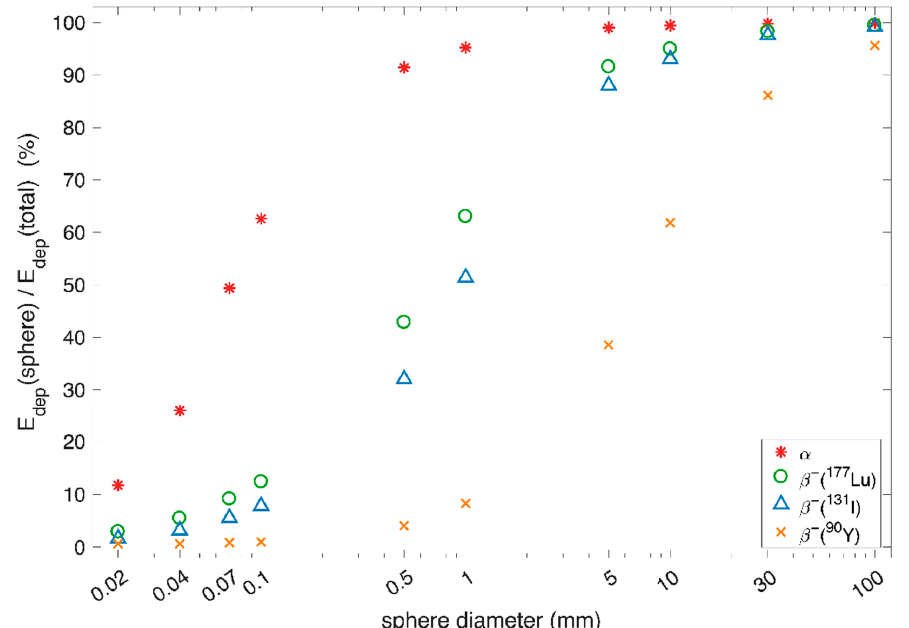
Figure 3. The figure shows energy deposited within a spherical source (E dep (sphere)) as a percentage of the total energy emitted (E dep (total)). The sphere source diameter ranged from 0.02 mm, to approximate a single cell, to 100 mm, to approximate a large tumour. Note that the x-axis is a log scale. Four different sources are shown, three pure beta sources with beta energies following the emission spectra for 90 Y, 177 Lu, and 131 I, and an alpha source with alpha energies of 5.5 MeV. For large spheres, most of the energy will be deposited inside the sphere regardless of type of